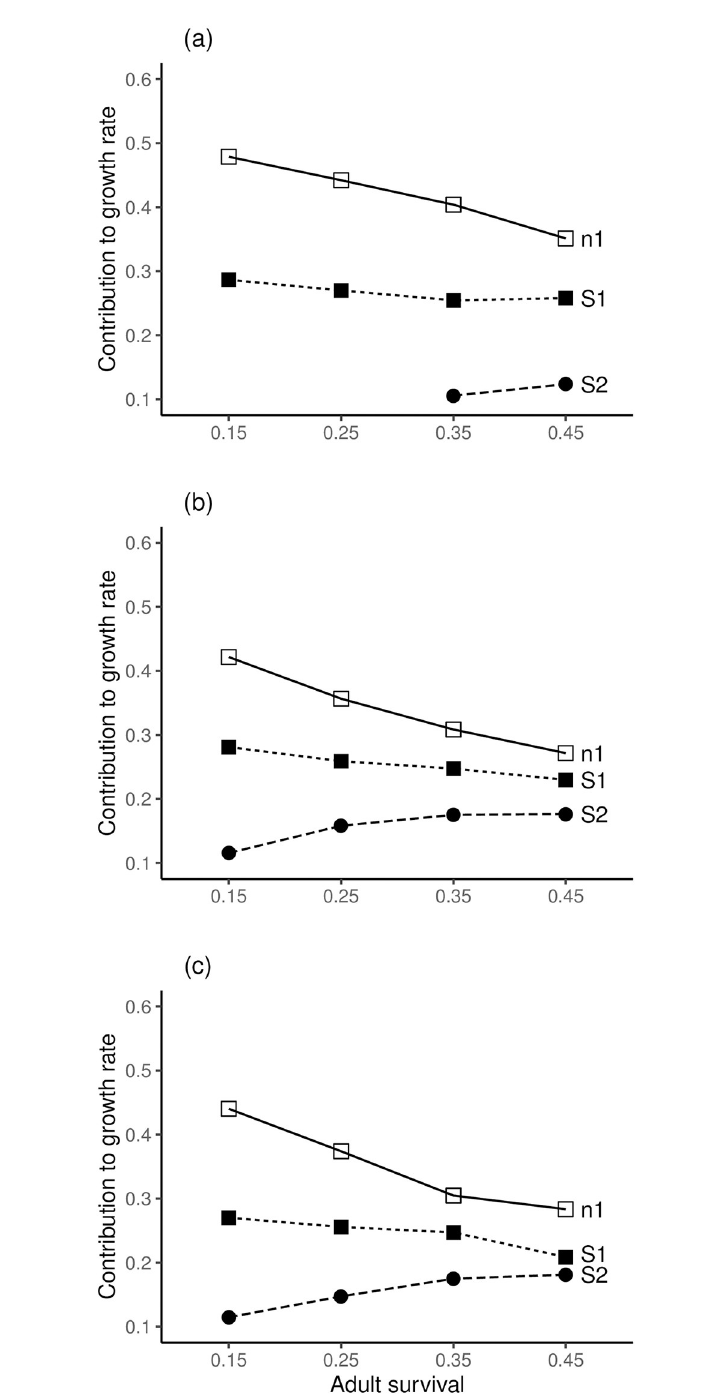
Fig 2. Simulations of age truncation for species with age 1 maturity. (a) H . amarus , (b) a hypothetical species "average fish", (c) E . motebensis ; proportional contributions exceeding 0.1 of s 2 S 1 and S 2 are survival probabilities for ages 1 and 2, respectively. A bar plot showing the contribution from each model parameter for each transient LTRE is provided in (S4–S6 Figs) for each species.